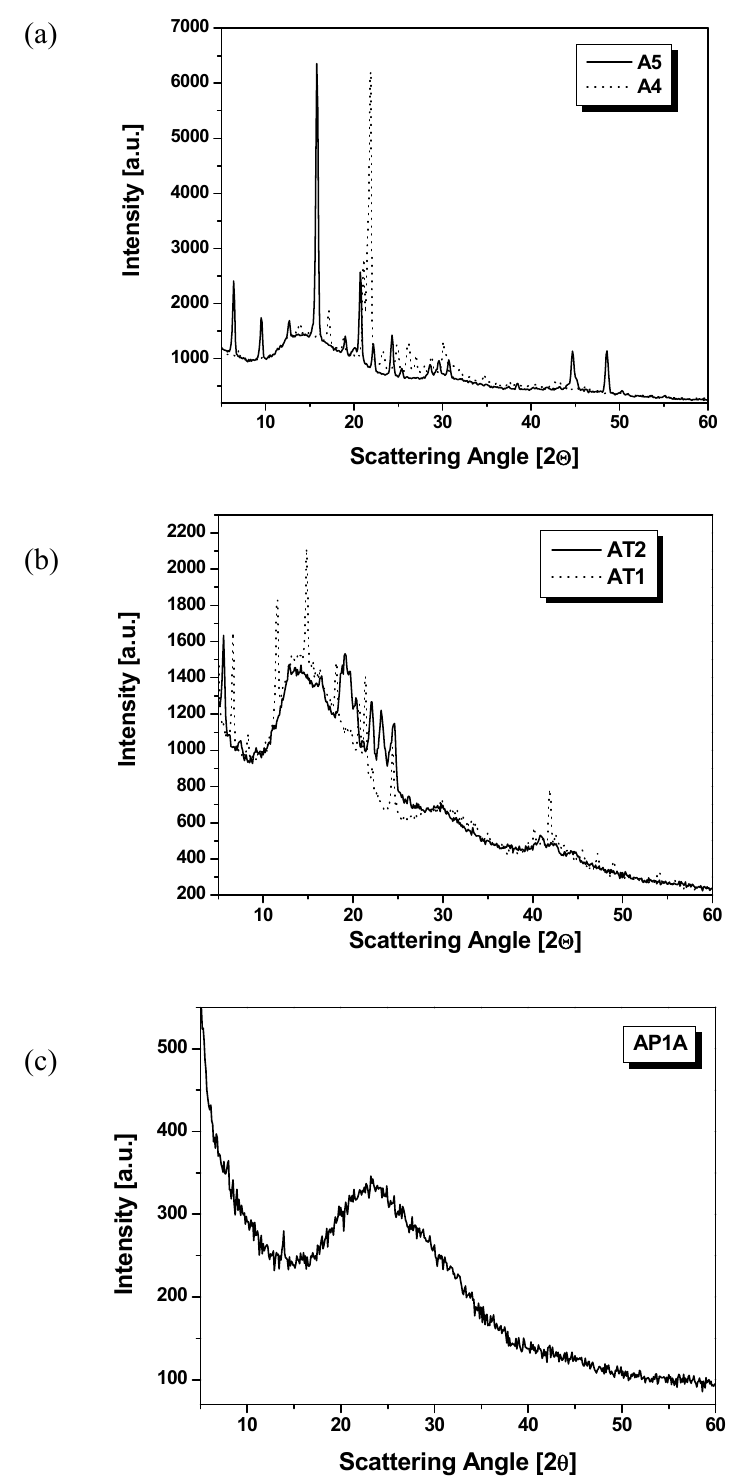
Figure 5. (a) X-ray profiles of symmetrical azomethines A4 and A5 . (b) X-ray profiles of symmetrical azomethines AT1 - AT2 . (c) X-ray profile of unsymmetrical azomethine AP1A . (seen at room temperature).